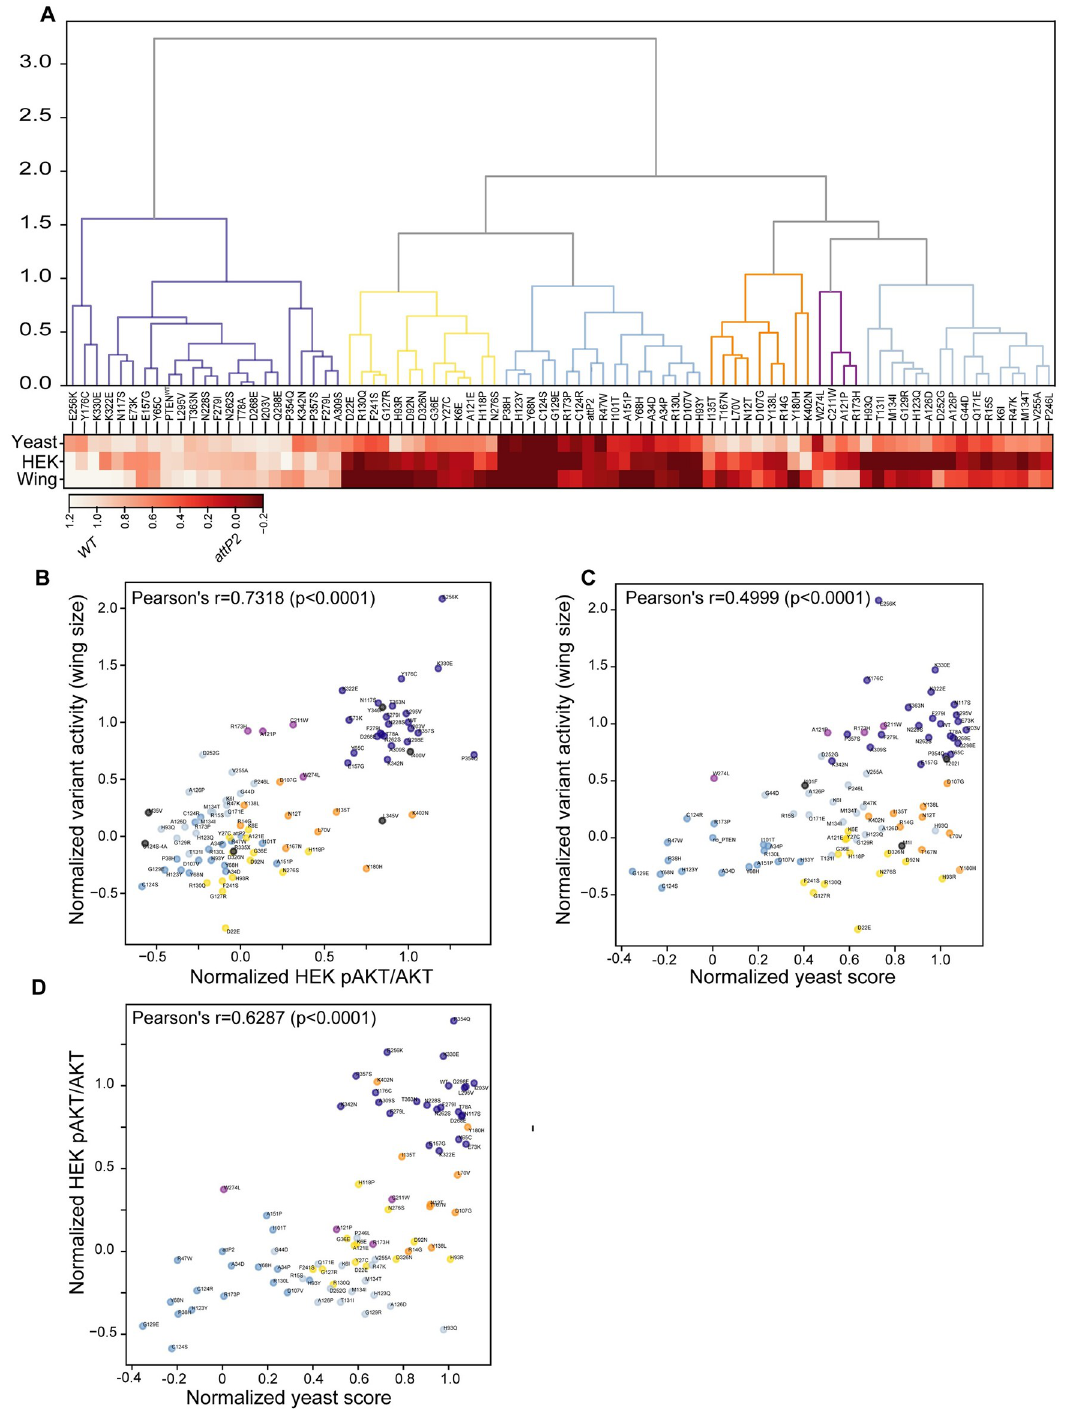
Fig 6. PTEN variant function in the wing assay compared to HEK and yeast assays. We tested the accuracy of the Drosophila wing size assay in predicting PTEN variant activity compared to available datasets assaying the ratio of pAKT/AKT immunoreactivity levels in HEK, or yeast growth dependent on PIP 3 to PlP 2 hydrolysis. ( A ) Hierarchical clustering to visualize functional similarities in normalized PTEN variant function from each assay, and a heatmap showing relative function. (B-D) . Pairwise correlation scatter plots between the assays. Each datum point indicates an individual normalized variant mean (where attP2 = 0 and PTEN-WT = 1) and each cluster is colour coded as in ( A) . A high correlation of the wing size and HEK assays support the accuracy of wing size